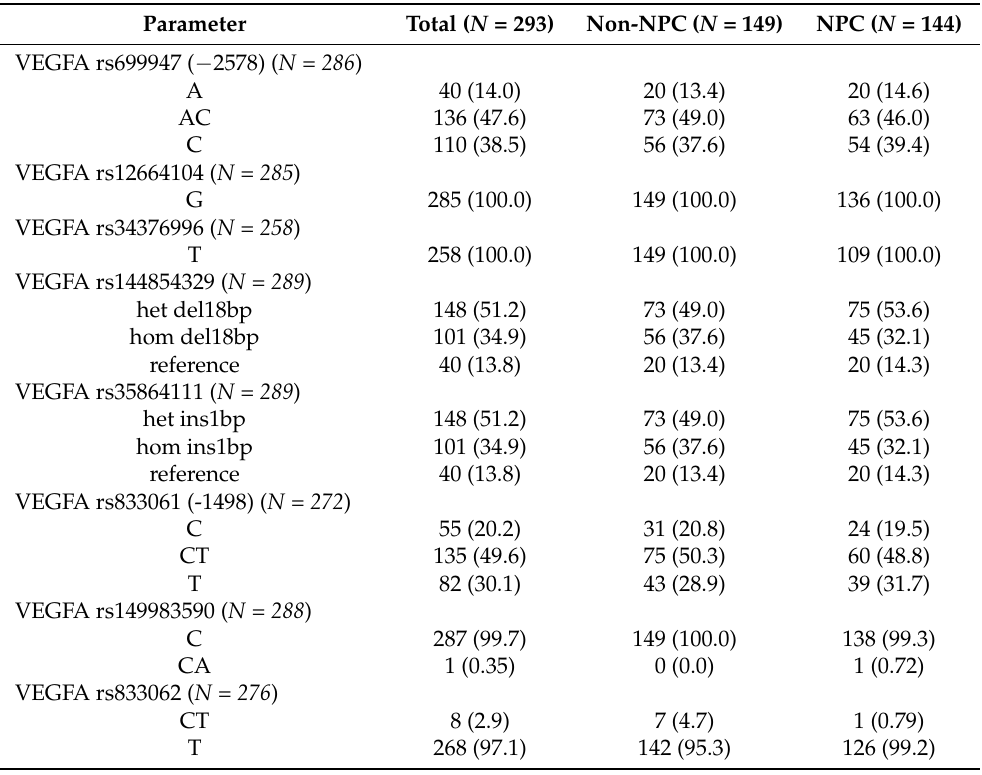
Table 2. Frequency distribution of the examined variants in the total cohort and by tumor